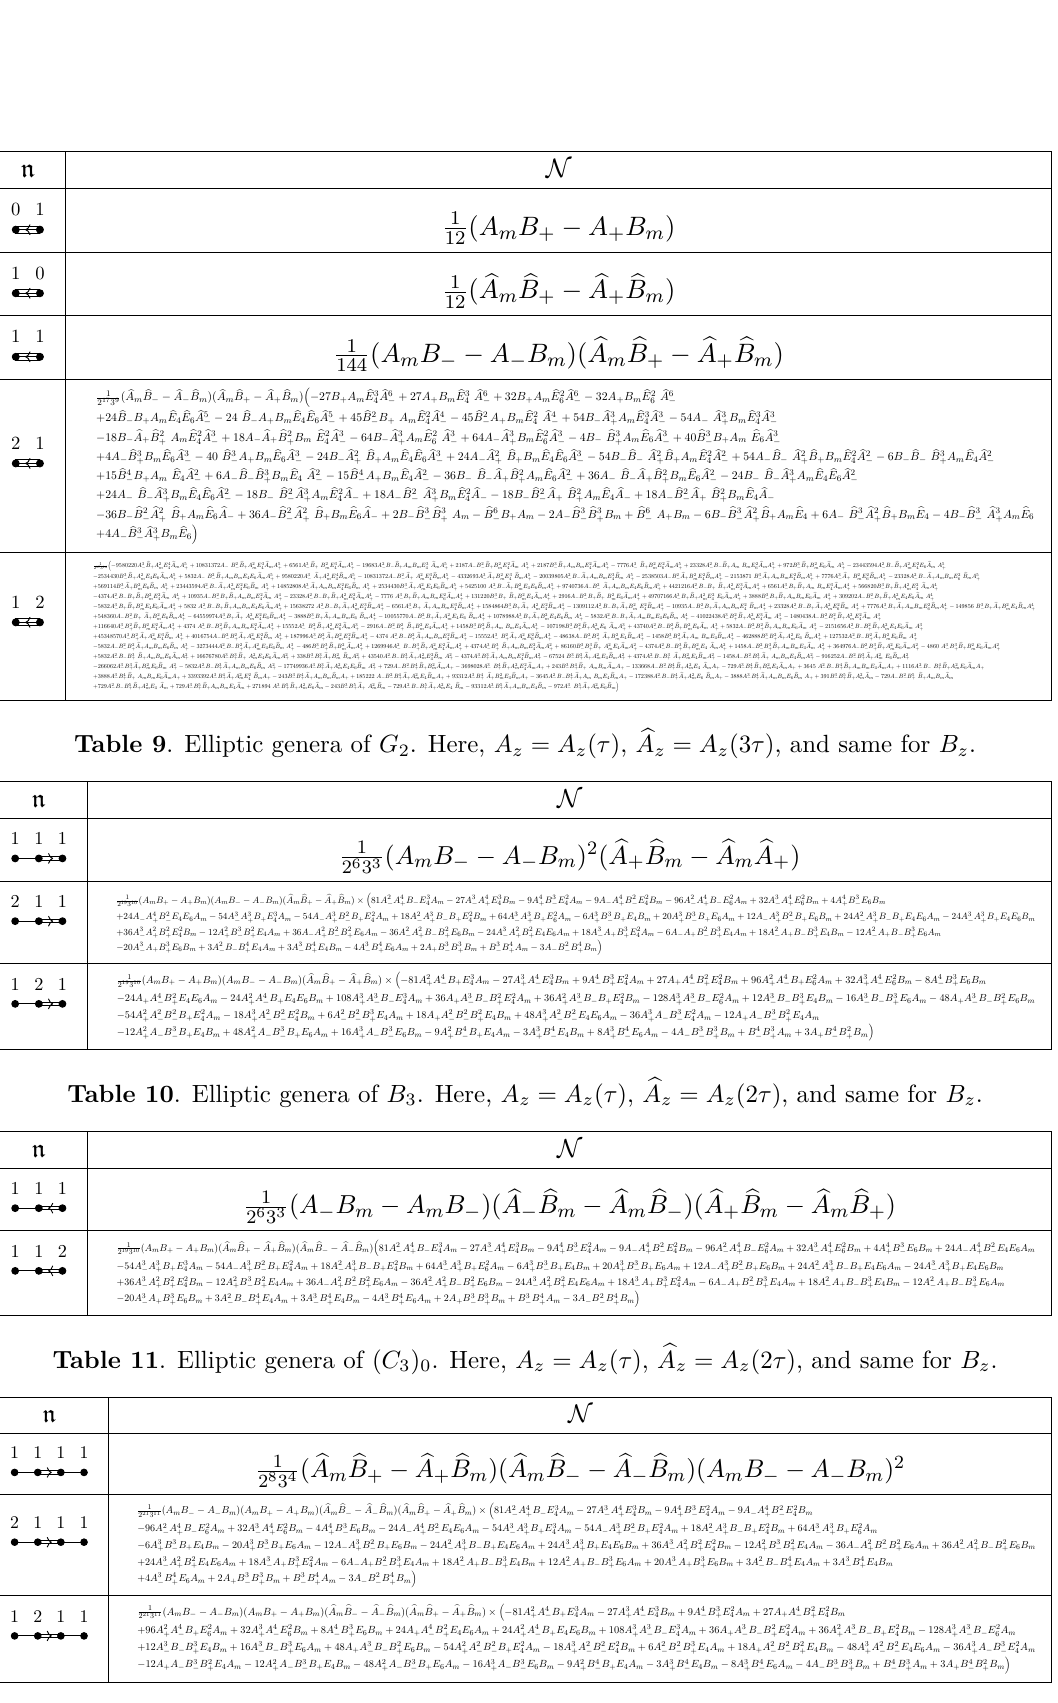
Table 12 . Elliptic genera of F 4 . Here, A z = A z ( τ ) , b A z = A z (2 τ ) , and same for B z .